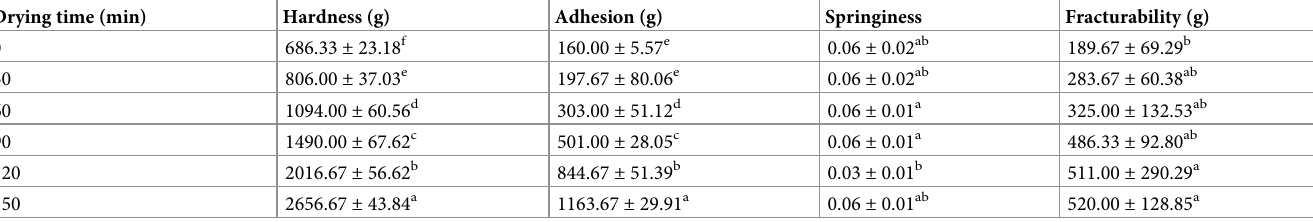
Table 3. Changes in textural parameters of AR pieces at different drying times. Drying time (min)